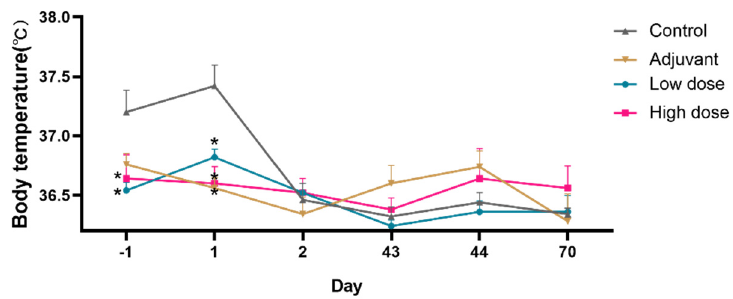
Figure 3. Time course of body temperature. Values are the average ± SEM of animals in each group. ANOVA and Dunnett’s test * p ≤ 0.05. Body temperature was measured in five animals in groups 1 to 4 before the first vaccine administration (D − 1), 2–5 h after the first dose (D1), the day after the first dose (D2), 2–5 h after the last dose (D43), the day after the last dose (D44), and before the end of the recovery period (D70). Table 1. Time course of body temperature.